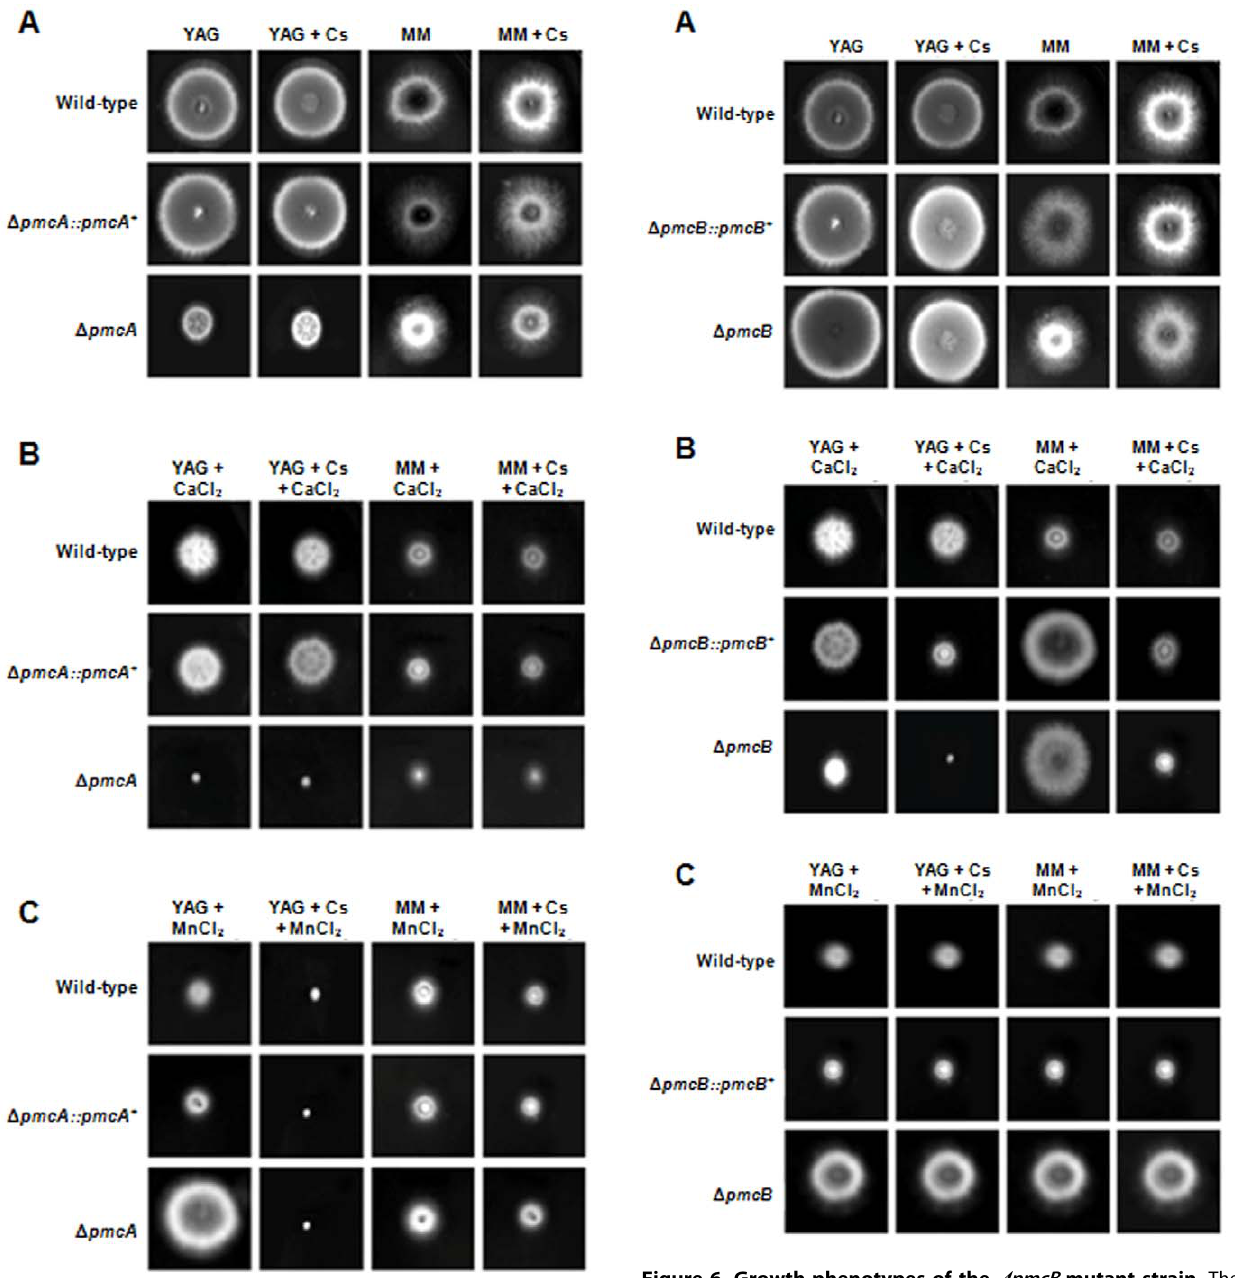
alveoli (Supplementary Figure S4, upper panels). At 12–14 hours post-infection, 80% of A. fumigatus conidia from the three strains had undergone comparable germination and primary hyphal production. Bronchoalveolar lavage was performed immediately using pre-warmed sterile saline and samples (BALFs) were snap frozen prior to RNA extraction and amplification. Within